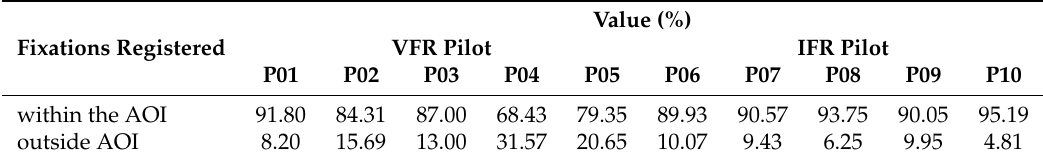
Table 9. Percentage contribution of fixations for the measurements with a blurred AOI outline.